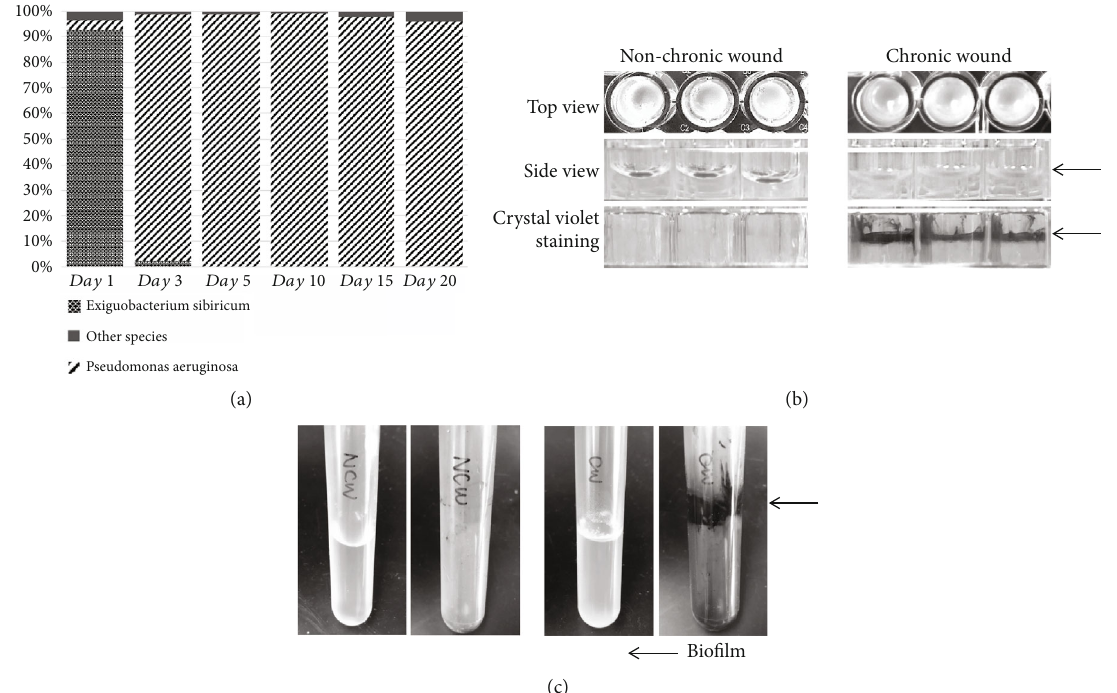
Figure 1: Chronic wound microbiome rich in P. aeruginosa formed strong bio fi lm in vitro . Microbiome rich in P. aeruginosa was collected from chronic wounds and cultured in vitro overnight. Similar cultures were performed with microbiome collected from nonchronic wound. (a) Bacterial species sequencing data using the 16S ITS region as the probe. In this particular animal, the wound became colonized with P. aeruginosa as early as day 3 postwounding and induction of chronicity. (b) Microbiome cultures in 96-well microtiter plates. Top view, side view, and side view with crystal violet staining. Microbiome from chronic wounds formed thick opaque bio fi lm on the air-liquid interface that can be stained with crystal violet (long arrow). Microbiome from nonchronic wounds did not form bio fi lm. Technical replicas of three wells of each condition. (c) Likewise, when cultured in tubes, microbiome from nonchronic wounds did not stain with crystal violet (left 2 tubes) whereas that from chronic wounds was stained with crystal violet (right 2